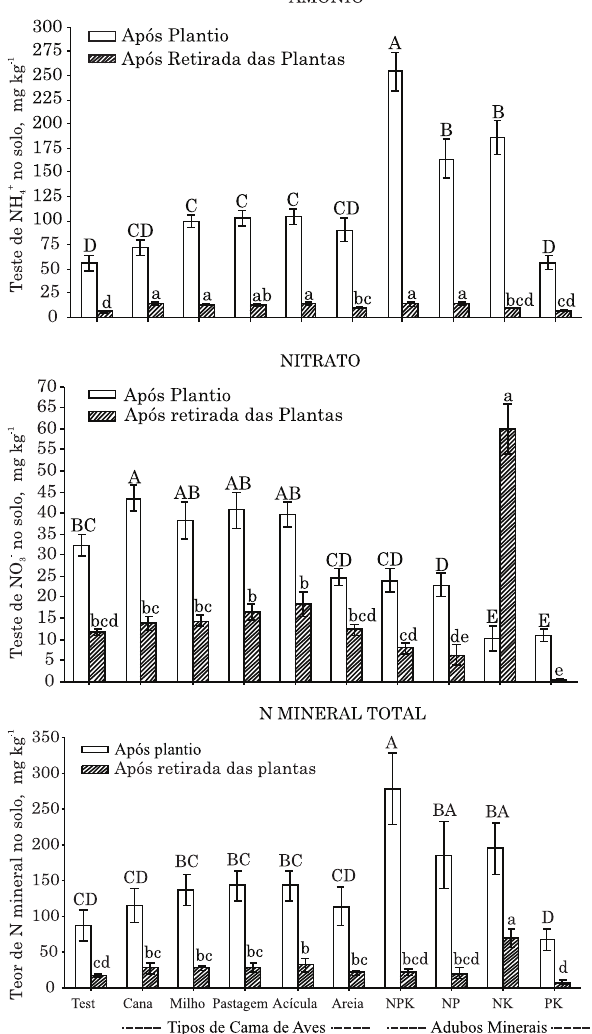
Figura 1. Teores de NH 4+ , NO 3- e N mineral total no solo (NH 4+ + NO 3- ), antes e após o cultivo de feijão, em razão da adição de fontes orgânicas e minerais. Letras maiúsculas referem-se às coletas após o plantio e letras minúsculas, atribui-se à coleta após a retirada das